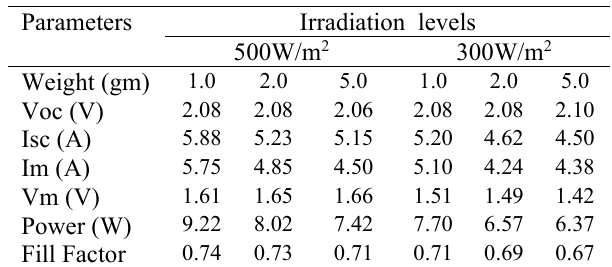
Figure 16. I-V and P-V characteristics of Sugar mill bagasse dust with reflector at 300W/m 2 Above results are used to calculate the FF, power and electrical parameter of the considered PV module; and are shown in Table 7 as, Table 7. Comparison of parameter with Sugar mill bagasse dust at 500/300 W/m 2